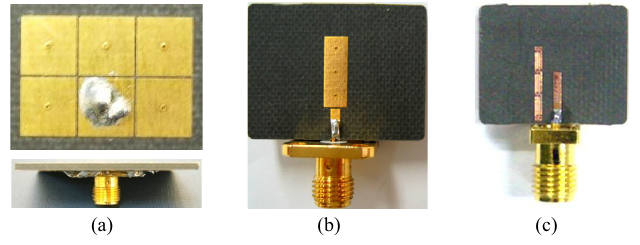
Fig. 3. ZOR antennas using the (a) DNG, (b) ENG,